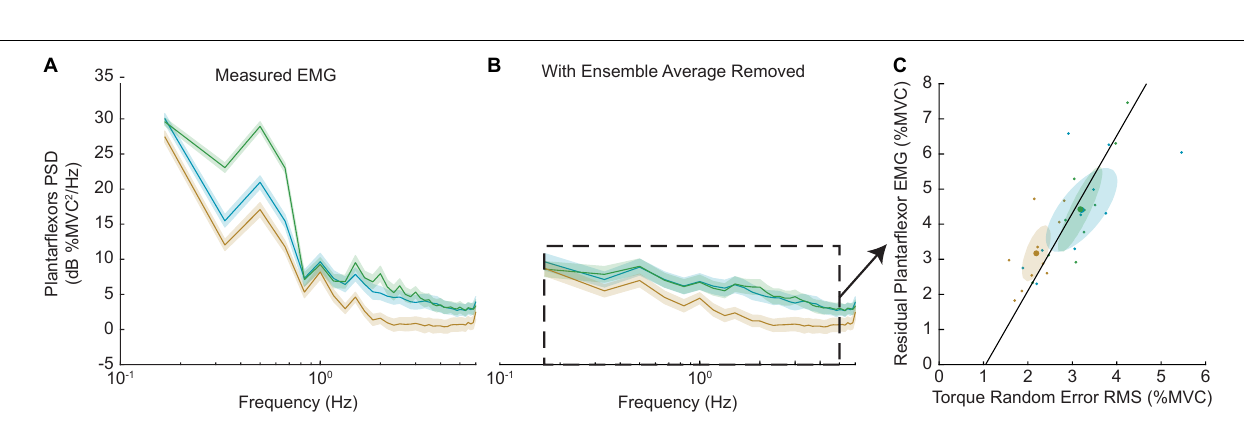
FIGURE 10 | Random error was correlated with increased cycle-to-cycle muscle activity variability. (A) Power spectra of the plantarflexor EMGs for all three tasks. Solid line shows group average, shaded areas show 95% confidence internals. As expected, the –K task had the greatest EMG activity. (B) Removing the ensemble average allowed us to investigate the EMG activity that differed from cycle-to-cycle. The + K task had less EMG than the other two tasks at all frequencies. (C) This residual EMG correlated strongly with the amount of random torque error across all subjects and tasks (black line). As a result, in the + K task subjects had less random torque error and less cycle-to-cycle variability in their